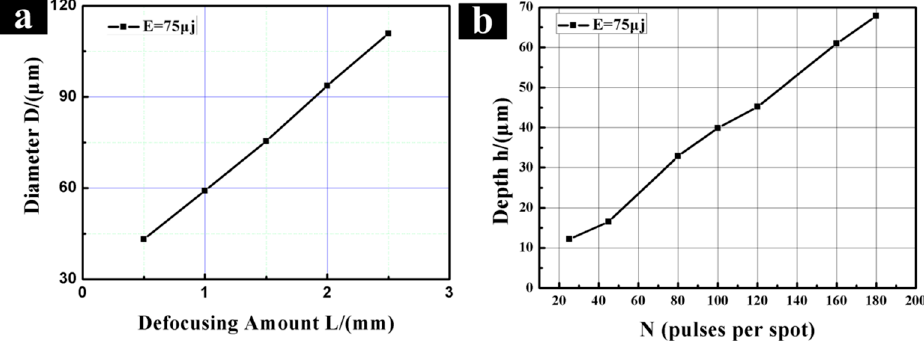
Figure 4. The relationship of the irradiation parameters with the desired geometry. ( a ) Diameter vs. the defocusing amount; ( b ) depth vs. the pulses per spot.